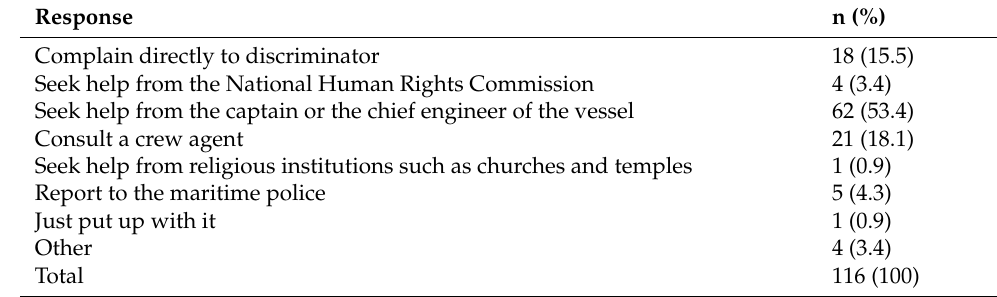
Table 4. Foreign seafarers’ responses to human rights violations or discrimination (multiple choice; n = 116).